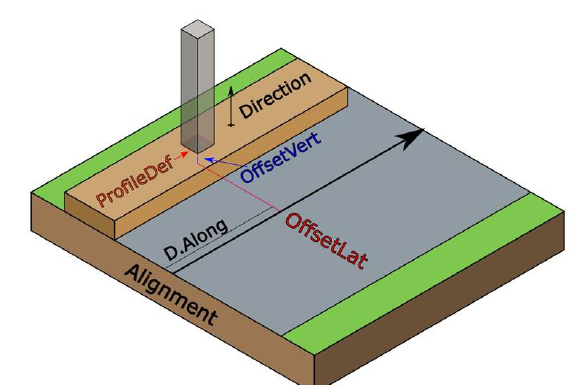
Figure 6. Schema of the modelling methodology. The position of an asset is defined relative to the alignment, and its geometry is extruded from a profile